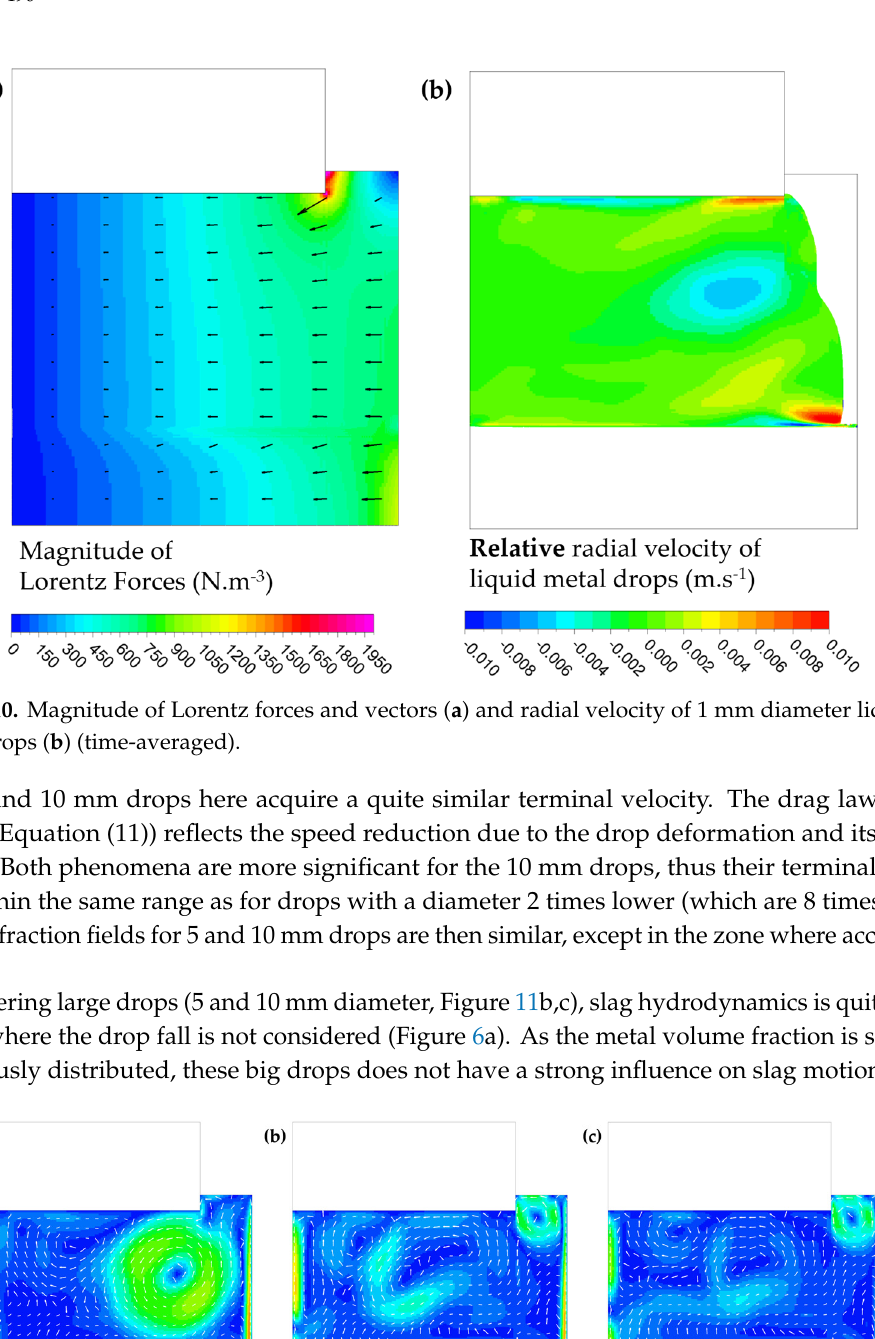
Figure 12. Difference of Lorentz forces (in %) between the case with 1 mm droplets and without droplets. The size of the drops also affects the heat exchange: small droplets are almost in thermal equilibrium with the slag, while larger ones are not, as illustrated in Figure 13. Slag temperature distribution is similar in these three cases, so the maximum overheat is reached for the smallest droplets. However, during their fall in the bottom part of the slag cap—which is cooler—these small droplets also lose more quickly their overheat, while bigger drops remain hotter than the surrounding slag. Hence, 10 mm drops bring more enthalpy to the melt pool than 1 mm drops. Drop overheats are compared in Figure 14. As already stated, in most engineering models of the ESR process, the enthalpy provided to the liquid pool by the drops is computed considering that they are in thermal equilibrium with the slag right above the interface. The cases presented here point out that this assumption is not verified for large droplets, which remains hotter than the slag above the melt pool.